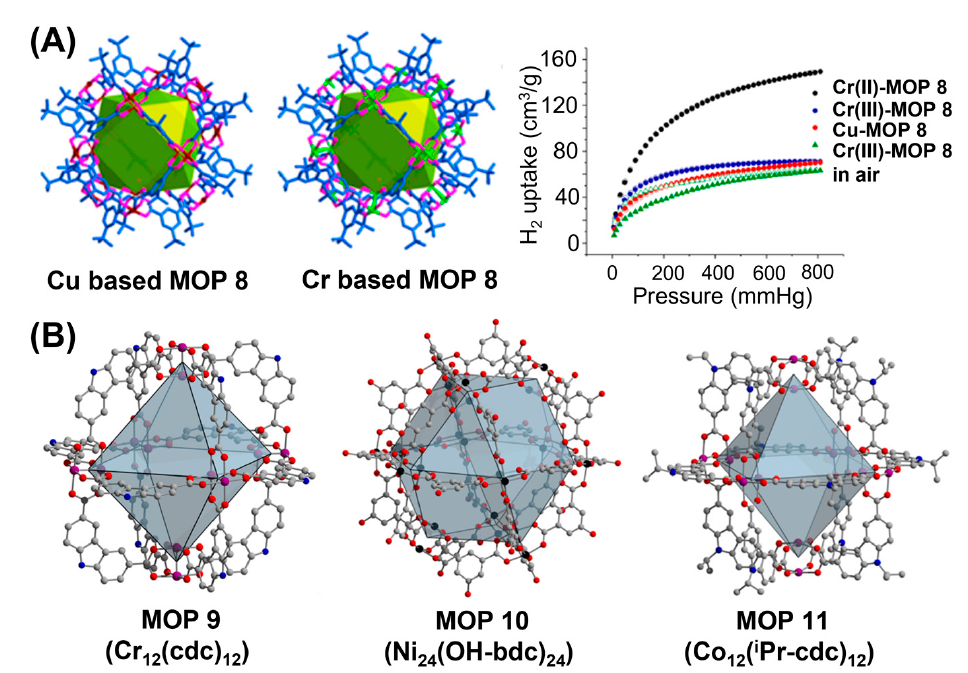
Figure 8. ( A ) Crystal structures of Cu II -based MOP 8 and Cr II -based MOP 8. H 2 adsorption isotherms of Cr(II)-MOP 8, Cr(III)-MOP 8, Cu(II)-MOP 8 and Cr(III)-MOP 8 kept in air for 1 month. ( B ) Crystal structures of MOP 9 (Cr 12 (cdc) 12 ), MOP 10 (Ni 24 (OH-bdc) 24 ) and MOP 11 (Co 12 ( i Pr-cdc) 12 ) are shown.